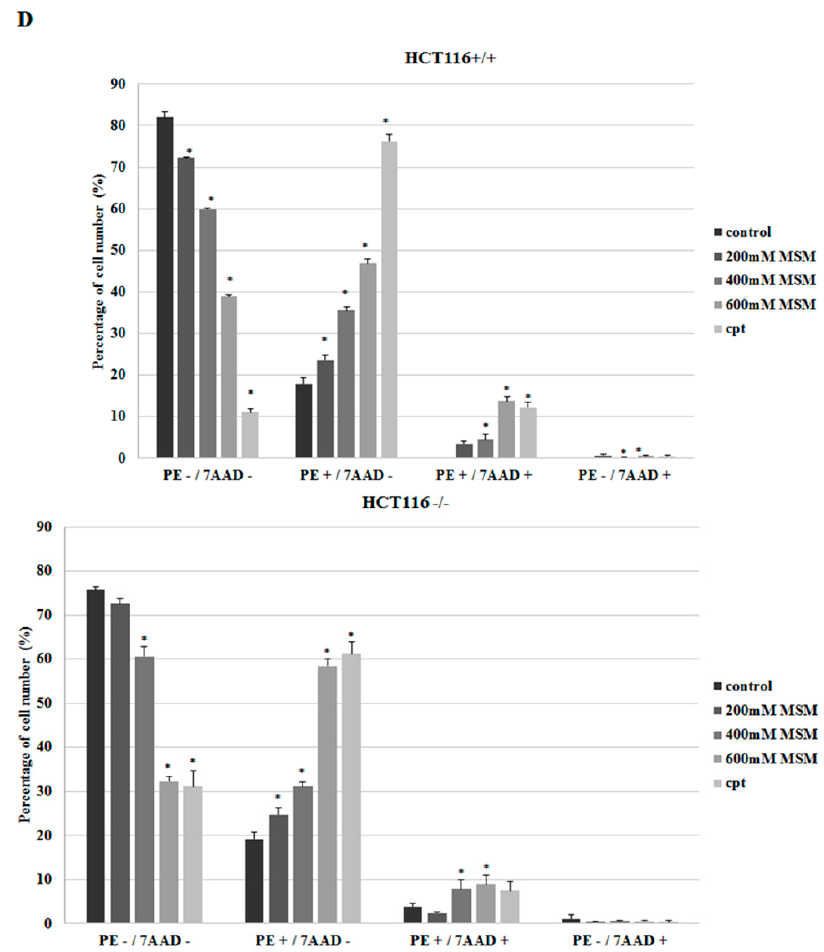
Figure 2. ( A ) Flow cytometric analysis of Annexin V-PE/7-AAD-stained HCT-116 p53 +/+ and p53 − / − colon cancer cells. HCT-116 colon cancer cells were incubated with MSM for 24 h before